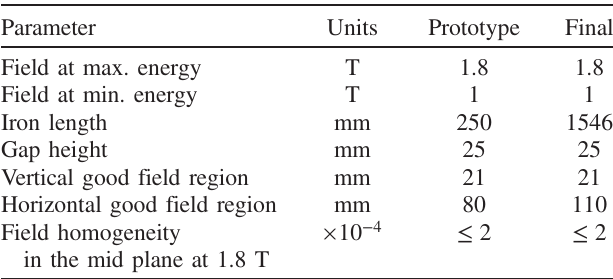
TABLE I. Magnet requirements.